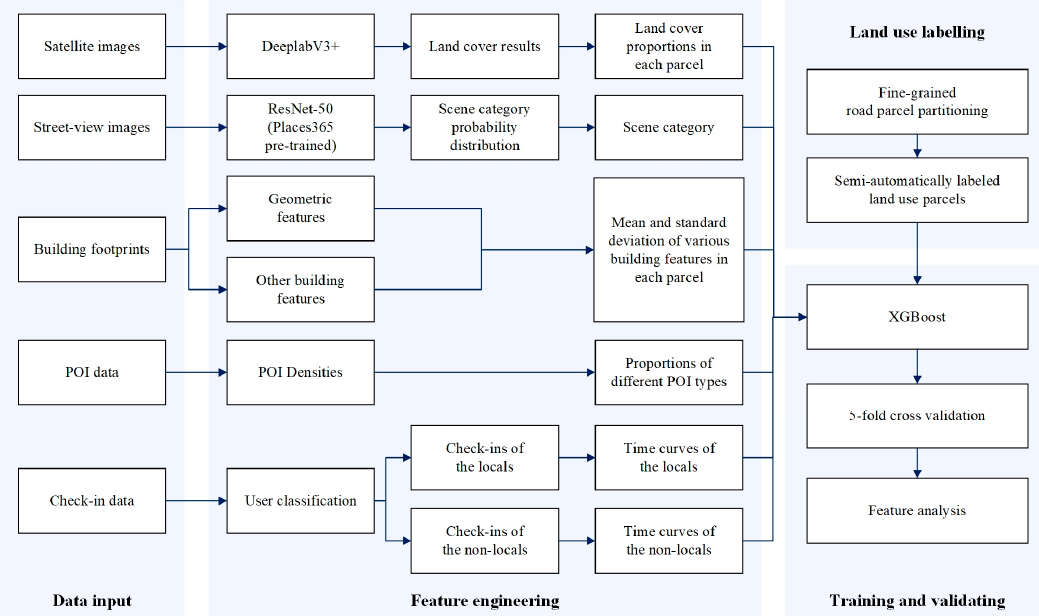
Figure 1. The ensemble learning based framework of urban land use mapping.